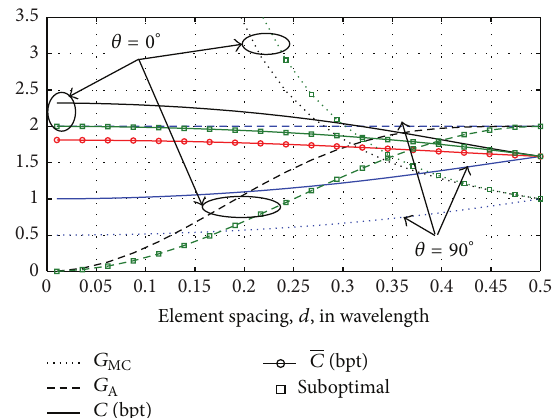
Figure 3: Aperture gain ( 𝐺 A ), mutual coupling gain ( 𝐺 MC ), instan- taneous capacity ( 𝐶 ), and mean capacity ( 𝐶 ) versus antenna spacing 𝑑 , for a SIMO system comprising two electrically short receive dipoles. All curves are based on a sample SISO SNR of zero dB. The graphs marked by “ ◻ ” are produced based on the suboptimal SMF processing with w = (1/√2)[−1,1] † .